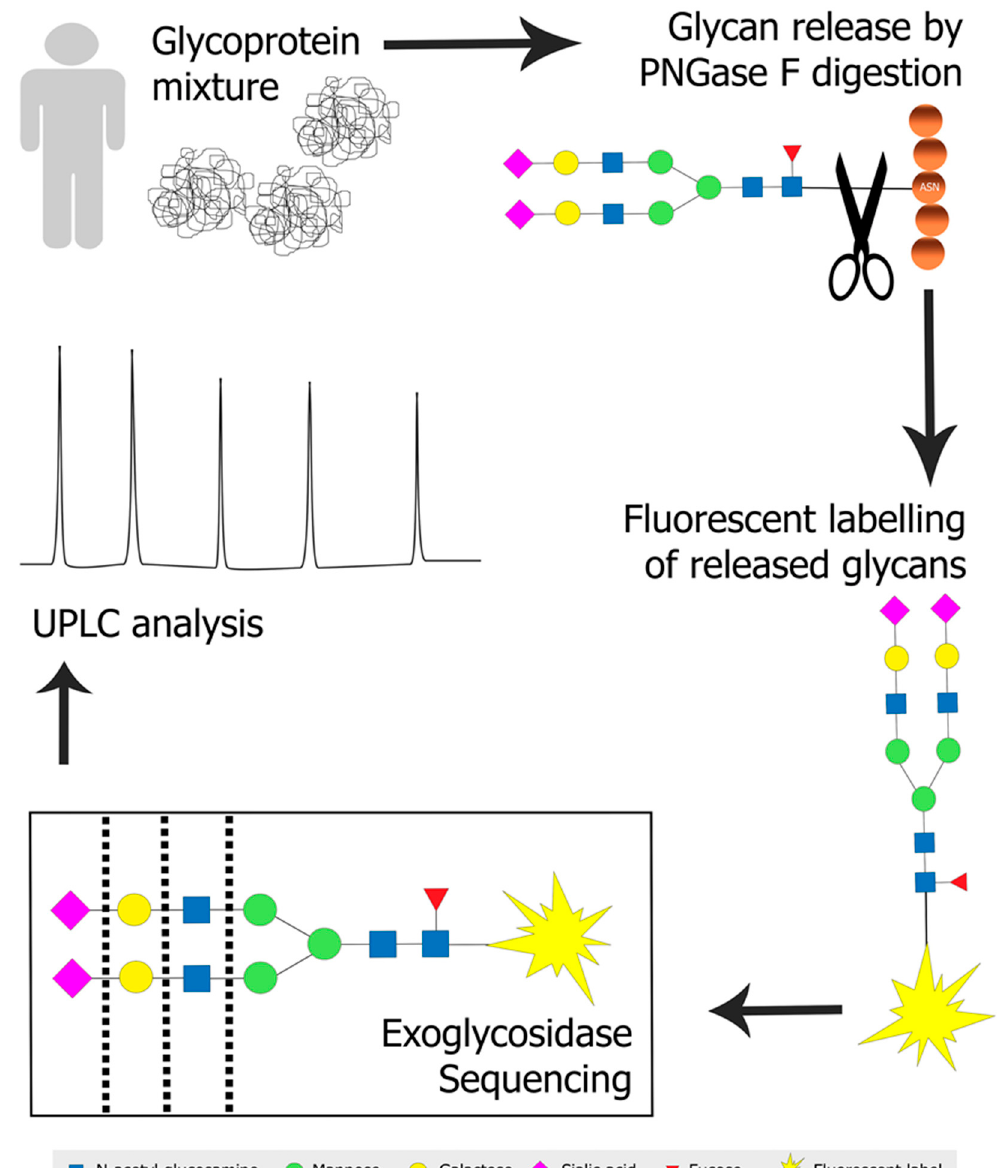
Figure 1. N-glycan profiling of a glycoprotein mixture. N-linked glycans are cleaved from glycoproteins by PNGase F digestion and fluorescently labelled in preparation for exoglycosidase sequencing and subsequent ultra-high performance liquid chromatography (UPLC) analysis. Terminal monosaccharides are removed from the non-reducing end of a glycan structure during an exoglycosidase digestion. Black dotted lines indicate the points of enzymatic digestion in this example of an exoglycosidase digestion. ASN, Asparagine residue in a protein chain; UPLC, ultra high performance liquid chromatography; PNGase F, peptide-N4-(N-acetyl- β -glucosaminyl) asparagine amidase. Images were created using Adobe Photoshop.